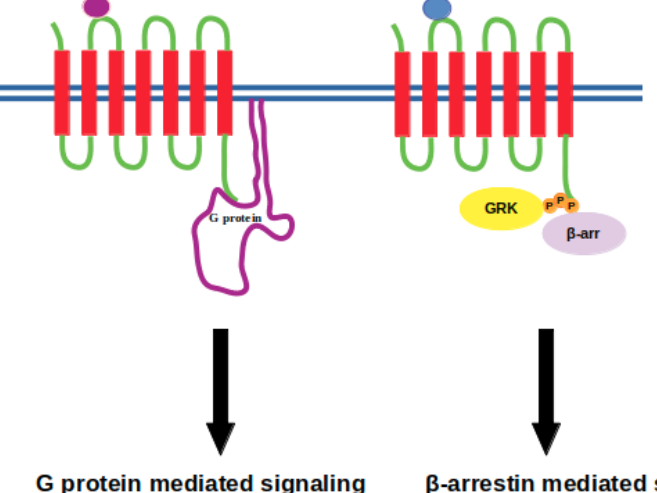
Figure 2. Purple and blue beads represent biased ligands where they initiate either G protein or β -arrestin mediated signaling, respectively. G protein-coupled receptor kinase is denoted by GRK and represented with yellow circle that phosphorylates the intracellular domain of the receptor, whilst β -arrestin is represented with a purple